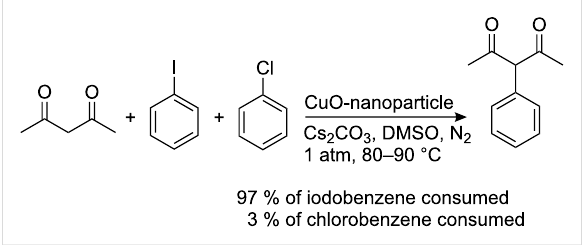
Table 2: CuO-nanoparticles catalyzed coupling reaction of acet- ylacetone and iodobenzene in various solvents a . Entry